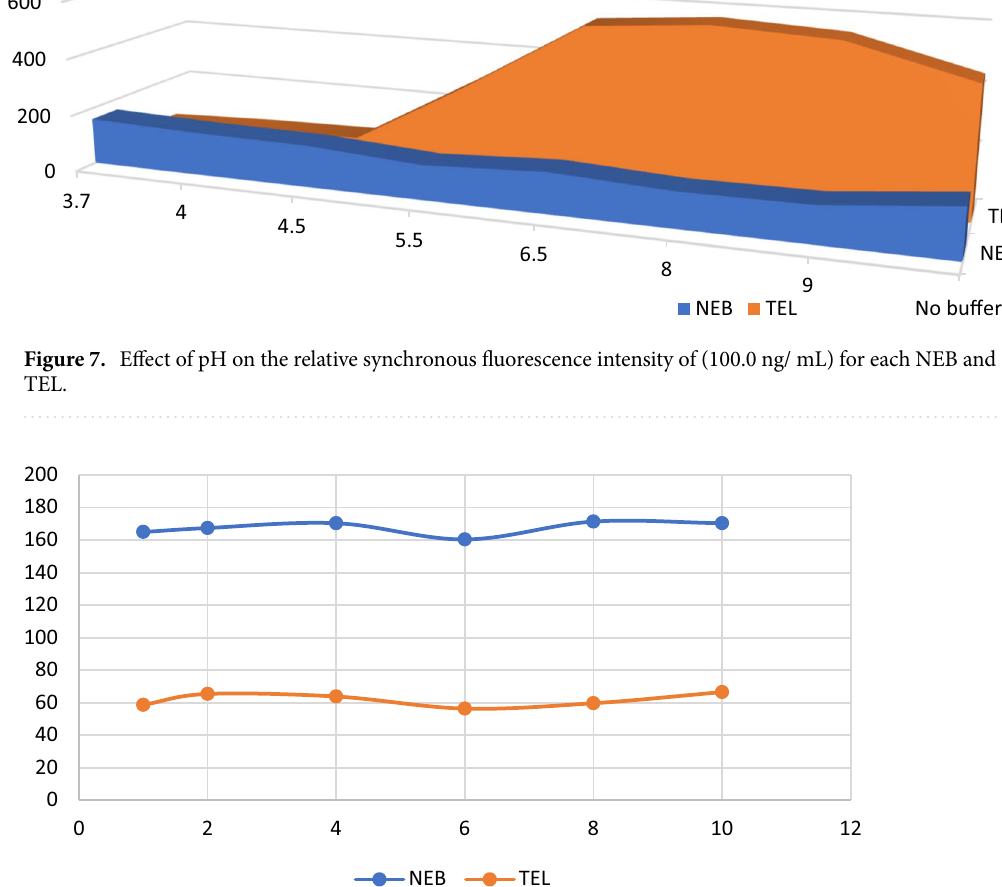
Figure 8. Effect of volume of buffer on the relative synchronous fluorescence intensity of (100.0 ng/ mL) for each NEB and